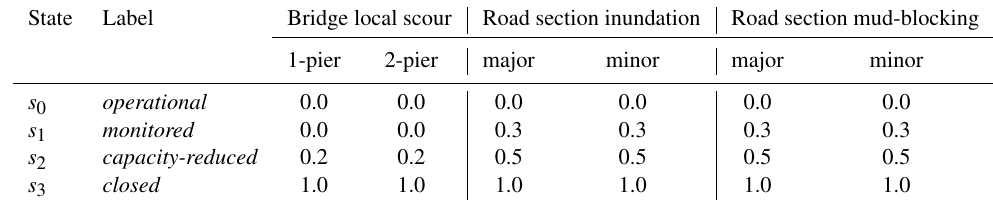
Figure 4. Fragility functions for (a) bridge local scour, (b) road section inundation, and (c) road section mud-blocking. The horizontal axis represents the intensity measure (cid:52) of the corresponding hazard. For (a) bridge local scour and (c) road section mud-blocking the axes are displayed in log-scale. The vertical axis represents the exceedance probabilities for the different damage states. The parameters µ and σ of these functions are given in Table 2. Table 3. Functional loss estimations for bridge local scour, road section inundation, and road section